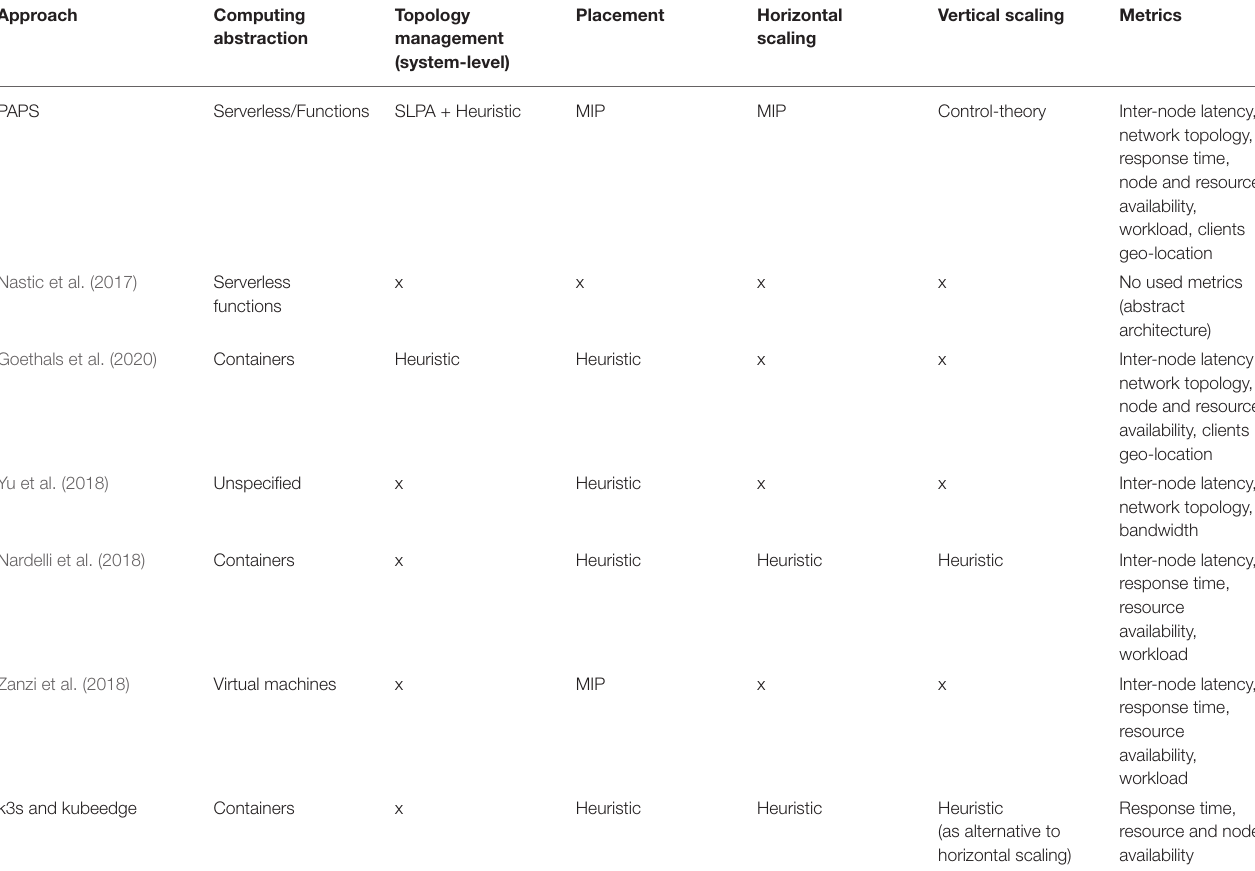
TABLE 2 | Comparison with the